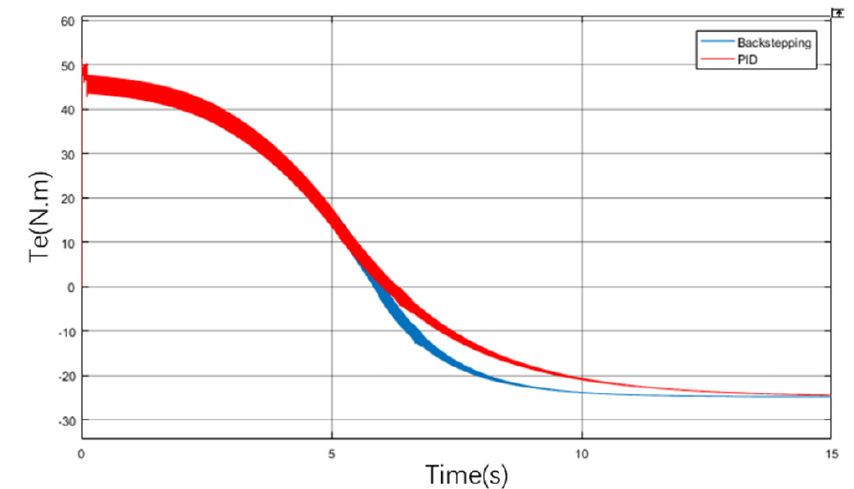
Figure 6. Comparison of electromagnetic torque curve between traditional PID and adaptive inver- sion controller.